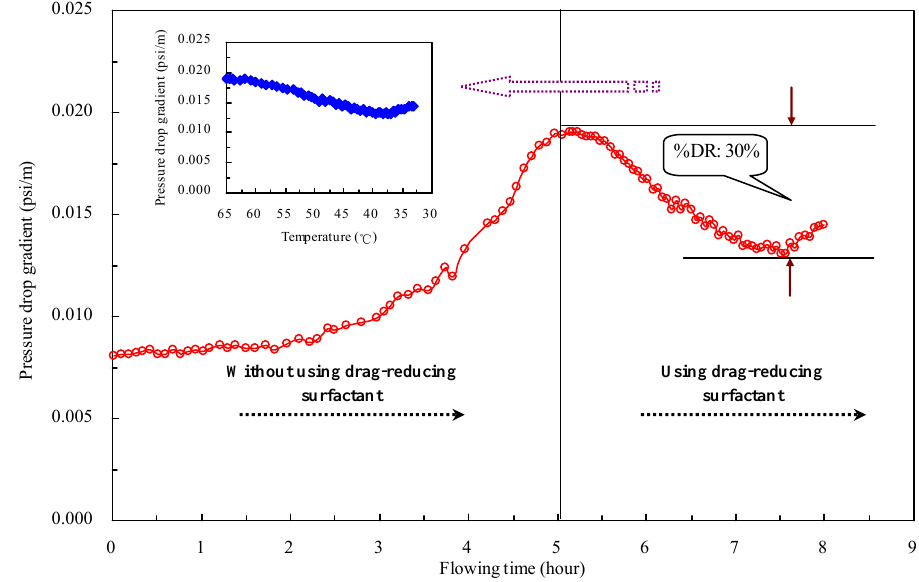
Figure 10. Variation of the pressure drop reduction before and after the drag-reducing surfactant addition (adding 100 mg/L of biobased surfactant).